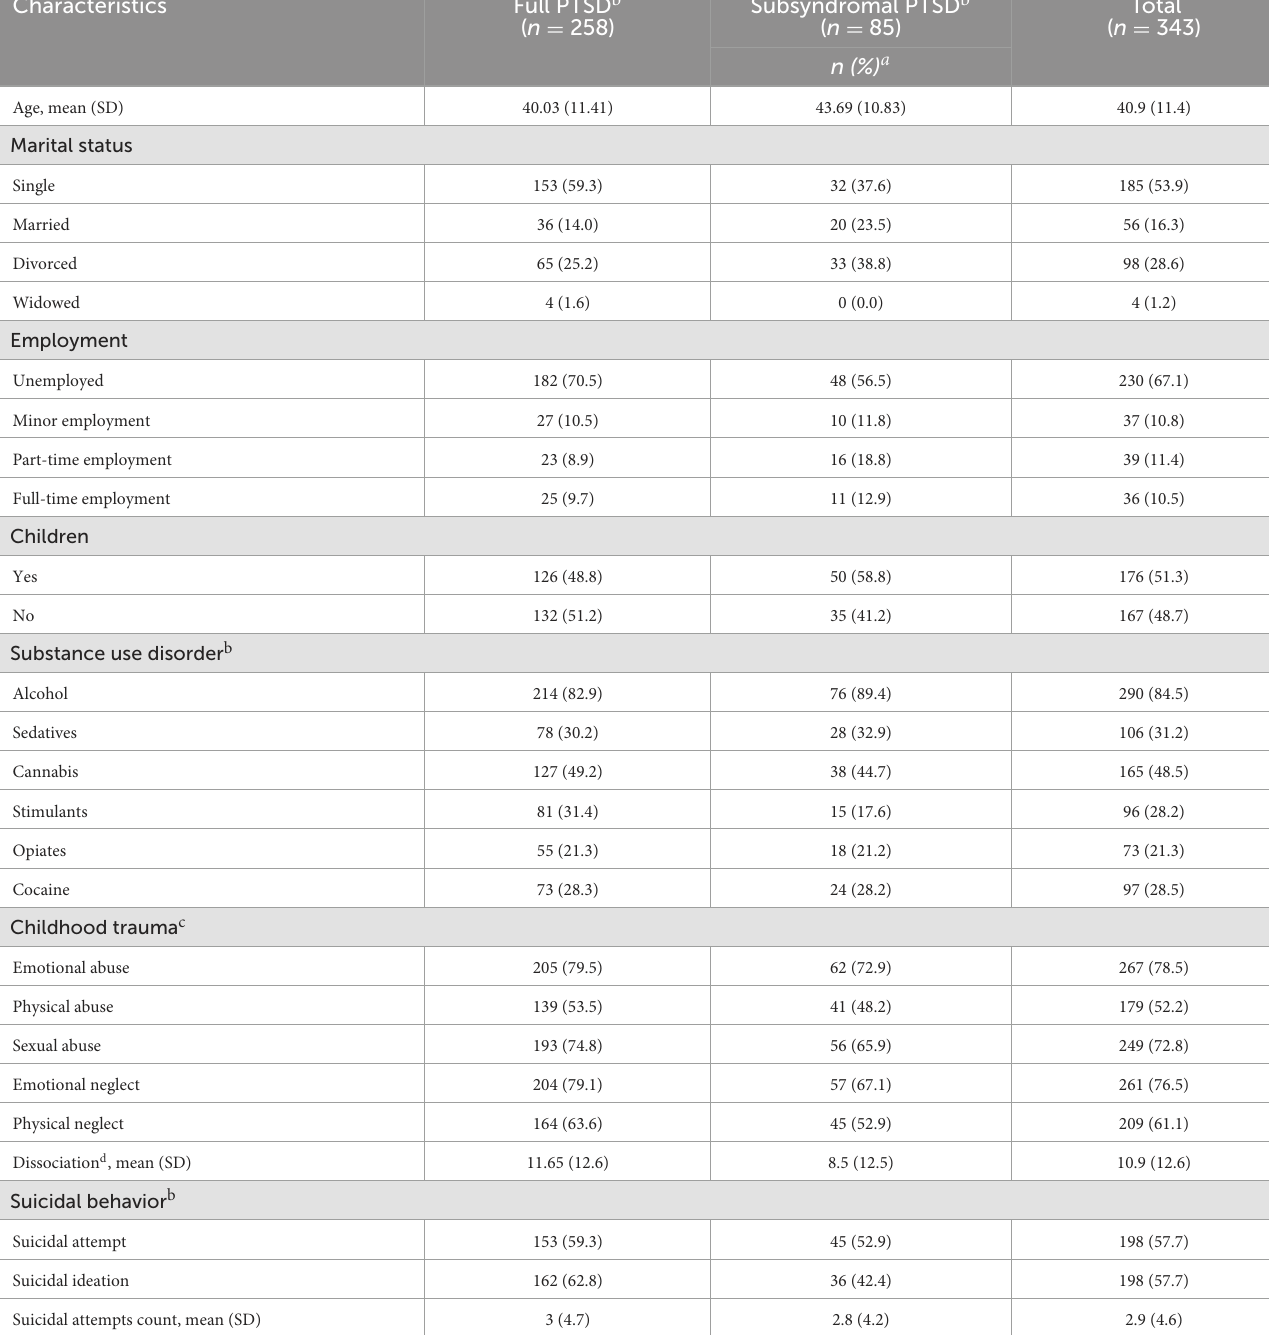
TABLE 1 Demographic and clinical sample